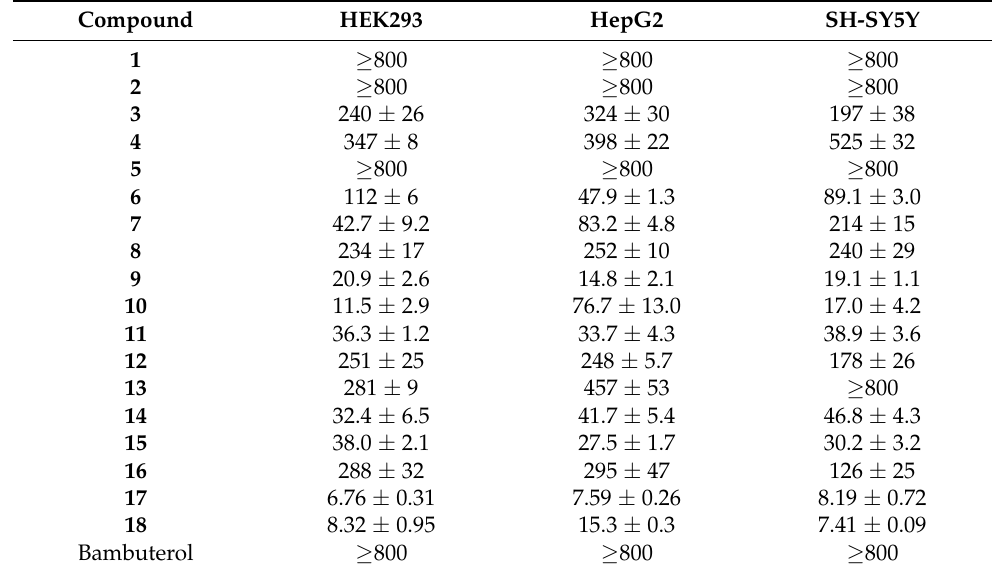
Table 2. The cytotoxicity of the tested compounds evaluated using MTS assay after 24 h cell exposure expressed as IC 50 values ± SE ( µ M). Compound